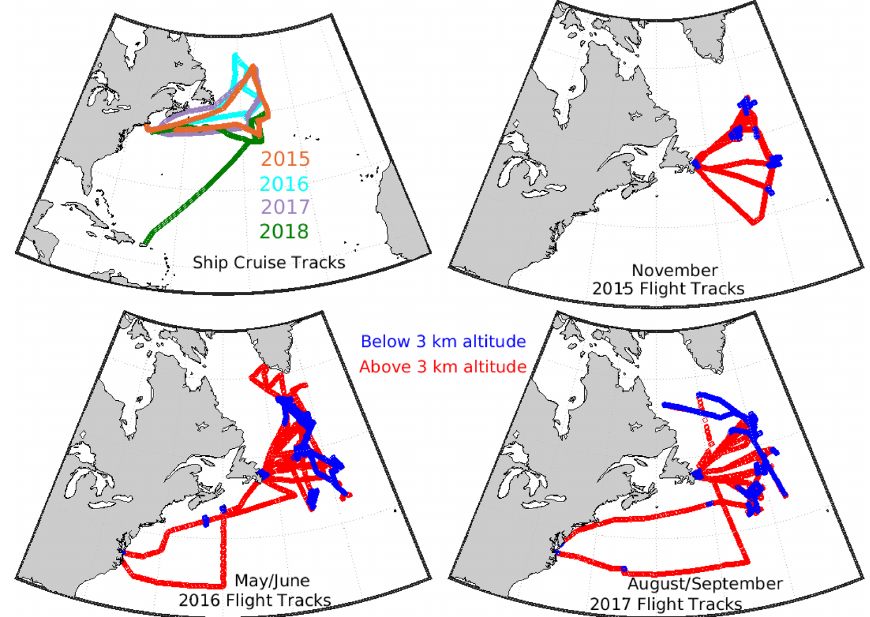
Figure 1. Cruise and aircraft tracks for the 2015–2018 NAAMES campaigns. Flight altitudes below 3km are color-coded in blue and above 3km in red. Ship-track campaigns are color-coded for each year as shown by the legend and as follows. Orange: November 2015 winter transition (bloom minima); cyan: May/June 2016 climax transition (bloom maxima); purple: August/September 2017 declining phase; and green: March/April 2018 accumulation